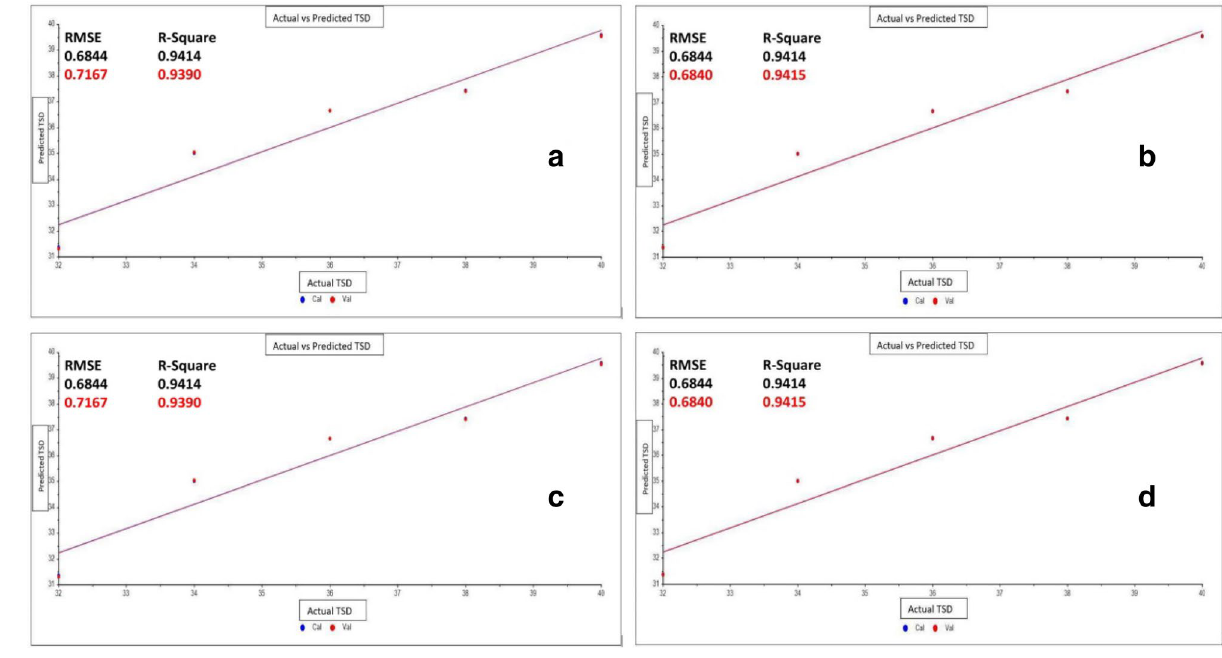
Figure 4. PCR plots of ( a ) actual vs cross validated prediction of TSD for semen (40%), ( b ) actual vs externally validated prediction of TSD for semen (40%), ( c ) actual vs cross validated prediction of TSD for saliva (100%), ( d ) actual vs externally validated prediction of TSD for saliva (100%).